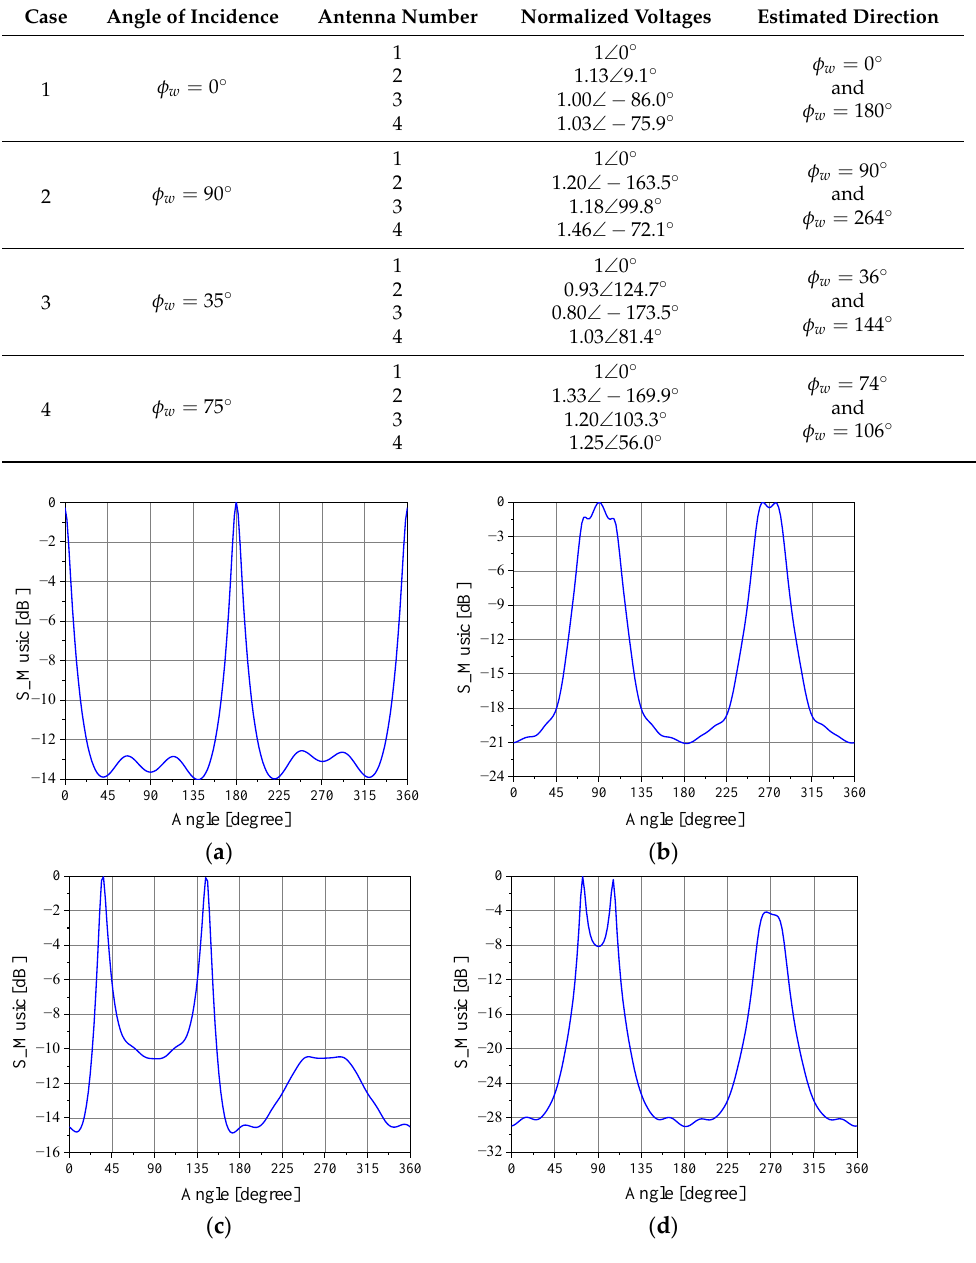
Figure 15. S MUSIC plots: ( a ) Case 1; ( b ) Case 2; ( c ) Case 3; ( d ) Case 4.